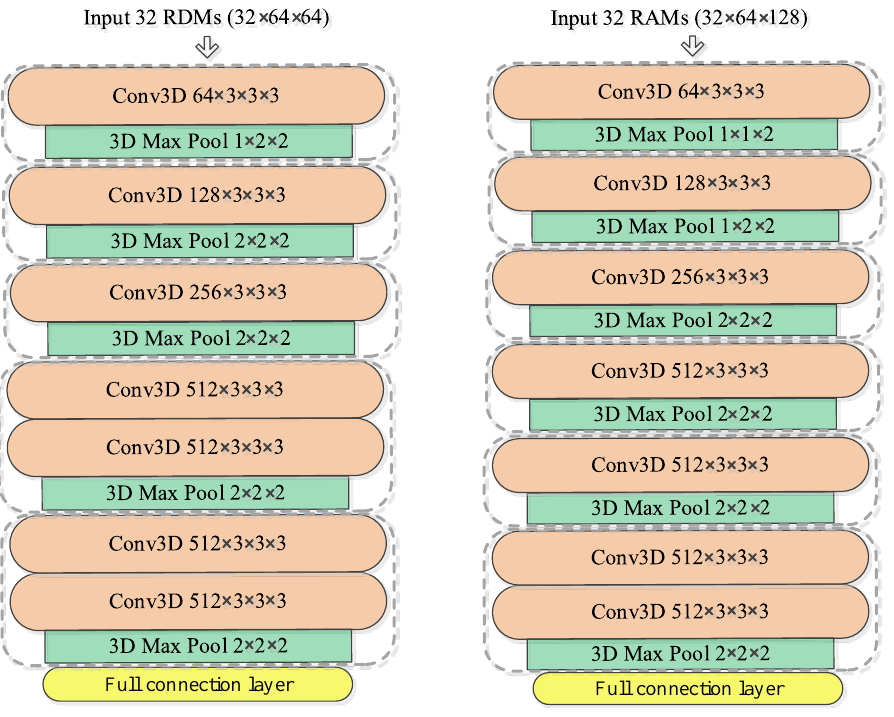
Figure 4. Architecture of dual